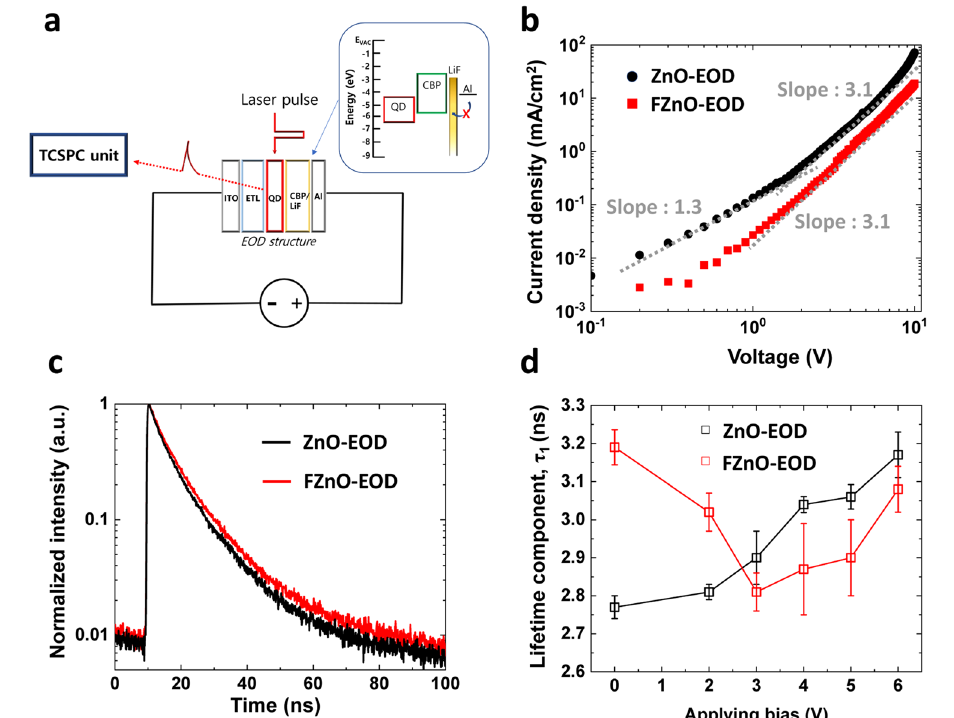
Fig. 4 a Schematic diagram of the EOD structure and the TRPL measurements scheme. The inset shows the energy levels of QD/CBP/LiF/ Al. b J-V characteristics of EODs with ZnO and FZnO. c TRPL signal from the QD layer in the EODs with ZnO and FZnO without bias. d The τ 1 values extracted from the TRPL signal under the different bias levels. The error bars indicate the standard deviation in the data collected from 6 samples in each